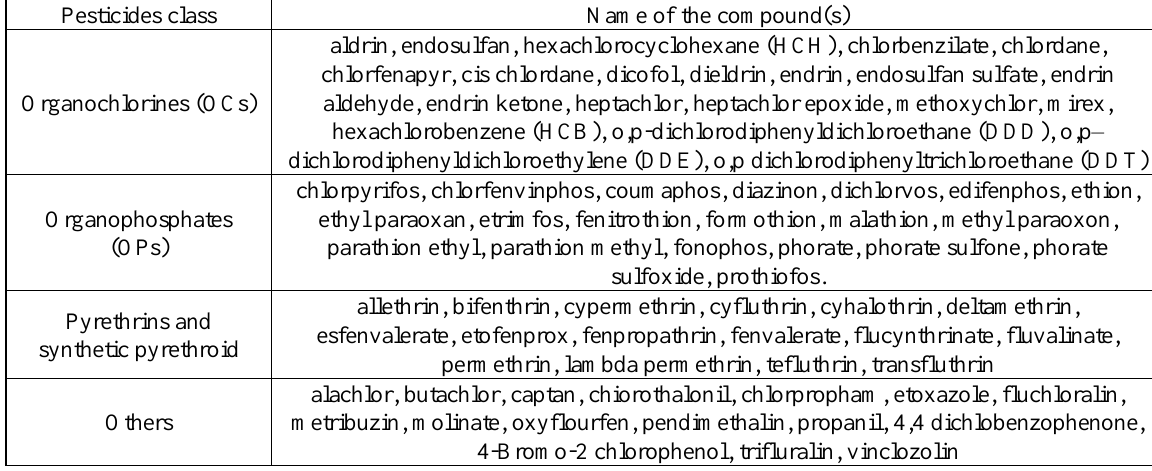
Table 2. Pesticide residues scanned in the cauliflower samples collected from Gurugram Pesticides class Name of the compound(s) Organochlorines